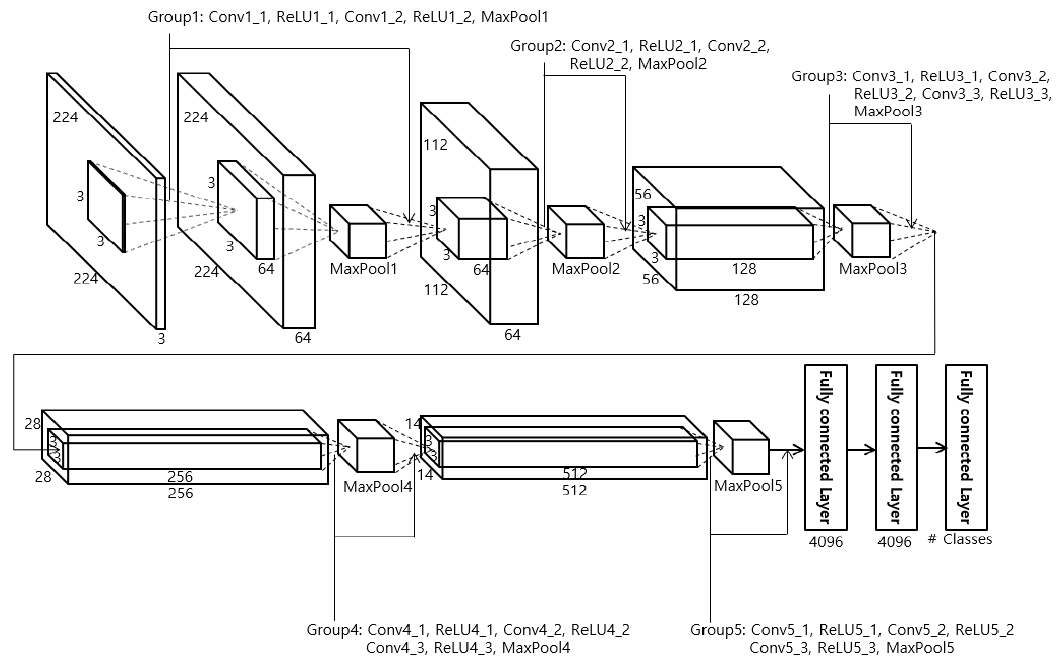
Figure 6. The structure of VGG Face-16 [3]. Conv, ReLU, and MaxPool represent convolutional layer, rectified linear unit layer, and max pooling layer, respectively.